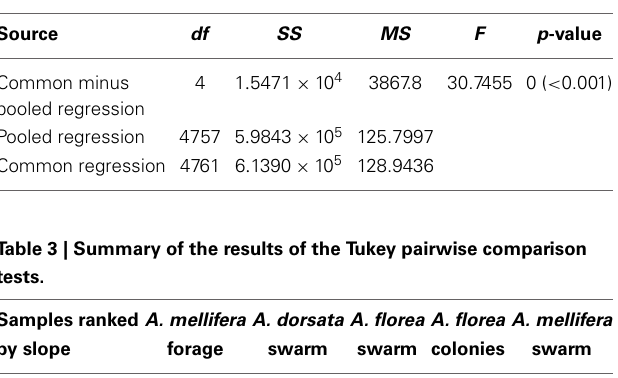
Table 2 | Results of our ANCOVA analysis comparing the slopes of the linear regressions detailed in Table 1.